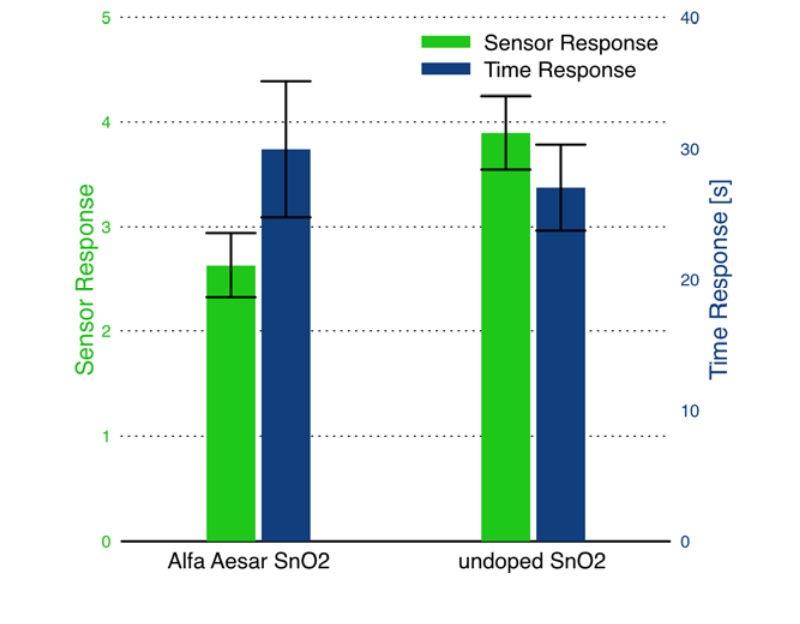
Figure 14. Comparison of sensor performance between combustion generated and commercial tin dioxide powders. The error bars represent the variation in response for multiple